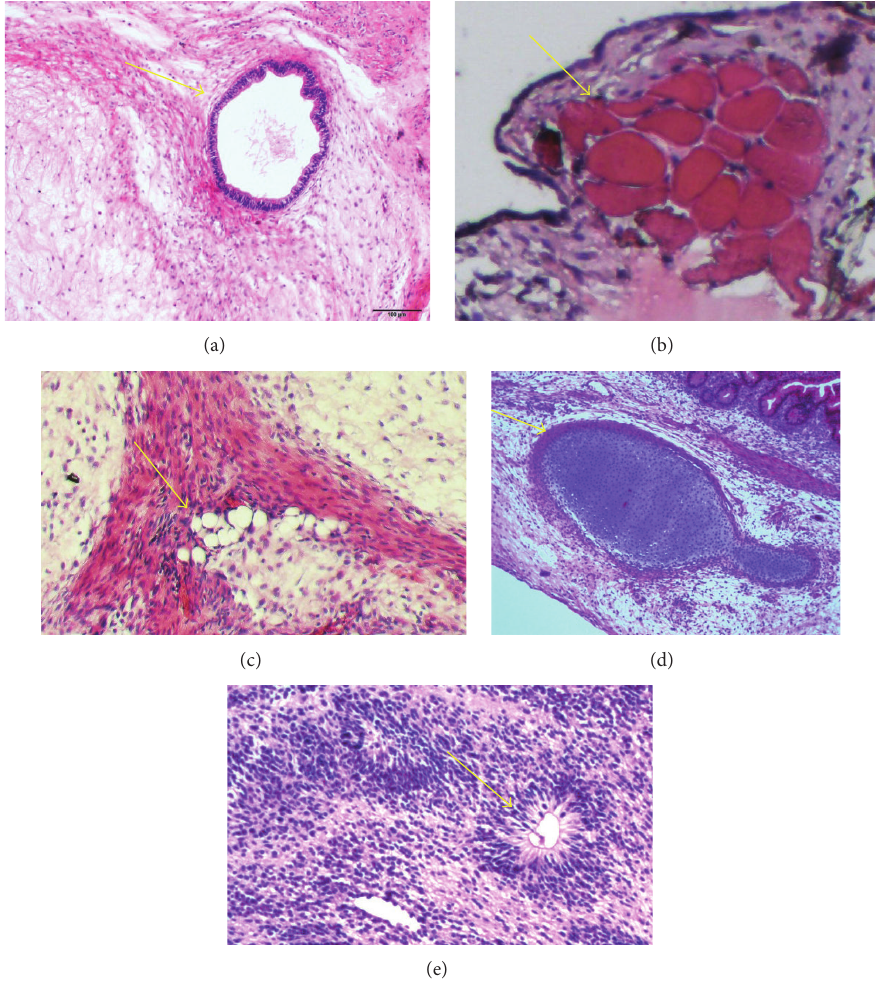
Figure 7: HE staining showed the teratoma had all three embryonic germ layers. (a) Endoderm (glands); ((b), (c), and (d)) mesodermal tissues of muscles, adipose, and cartilage, respectively; (e) ectoderm